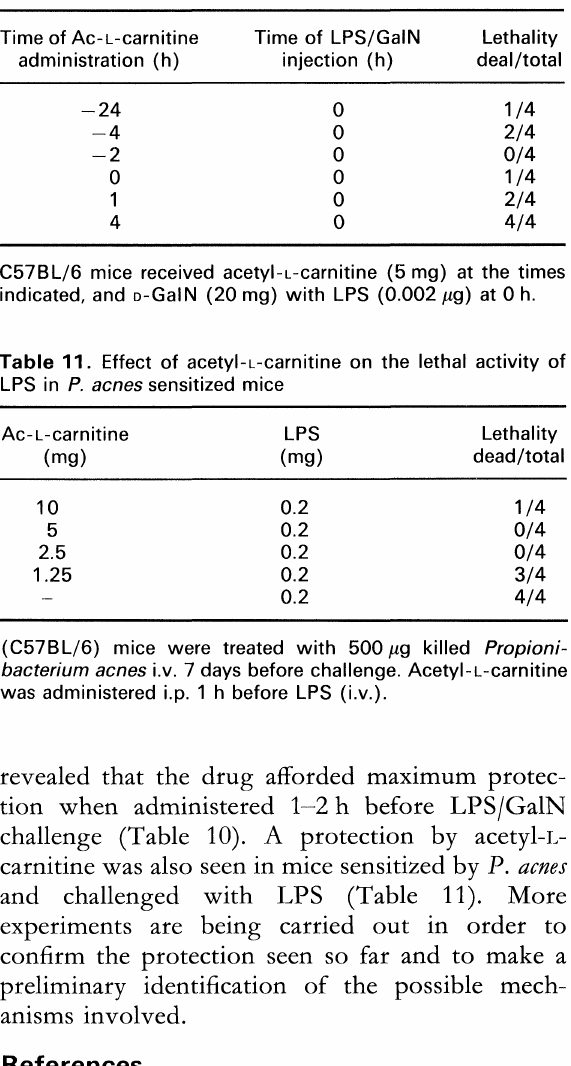
Table 8. Effect of acetyI-L-carnitine on the lethal activity of LPS in D-GaIN sensitized mice Ac-L-carnitine